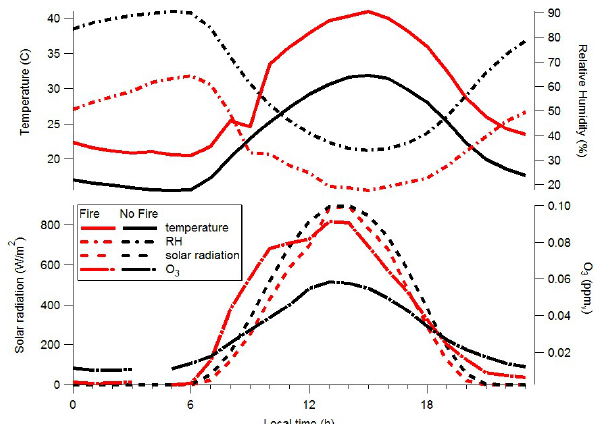
Fig. 2. Diurnal averages of meteorological parameters (Santa Fe Dam station) and O 3 concentrations during the fire- and non-fire